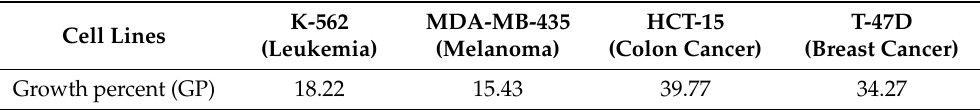
Table 2. The anticancer activity of N-(2,4-dimethylphenyl)-5-(4-hydroxyphenyl)-1,3,4-oxadiazol-2- amine against various cell